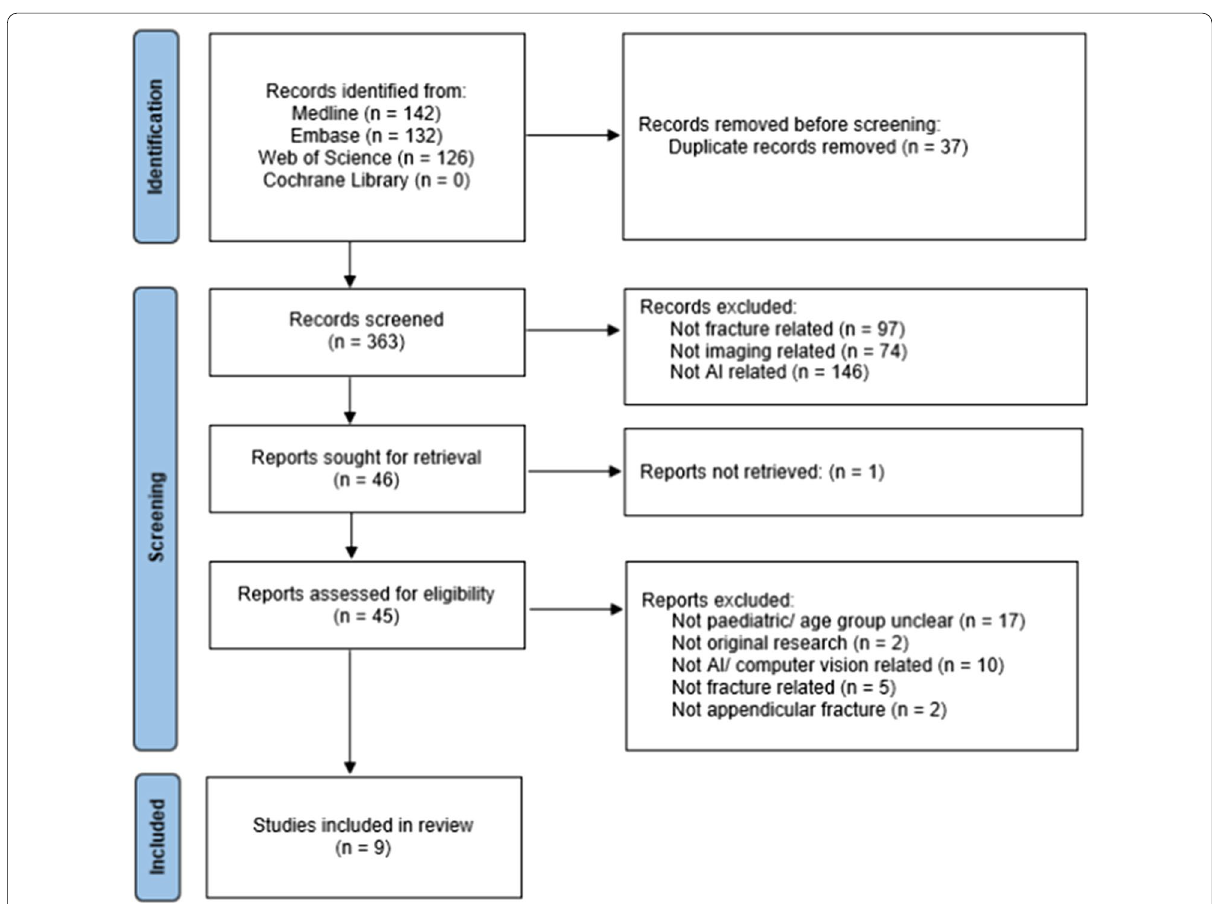
Fig. 1 PRISMA flow chart for the study search and